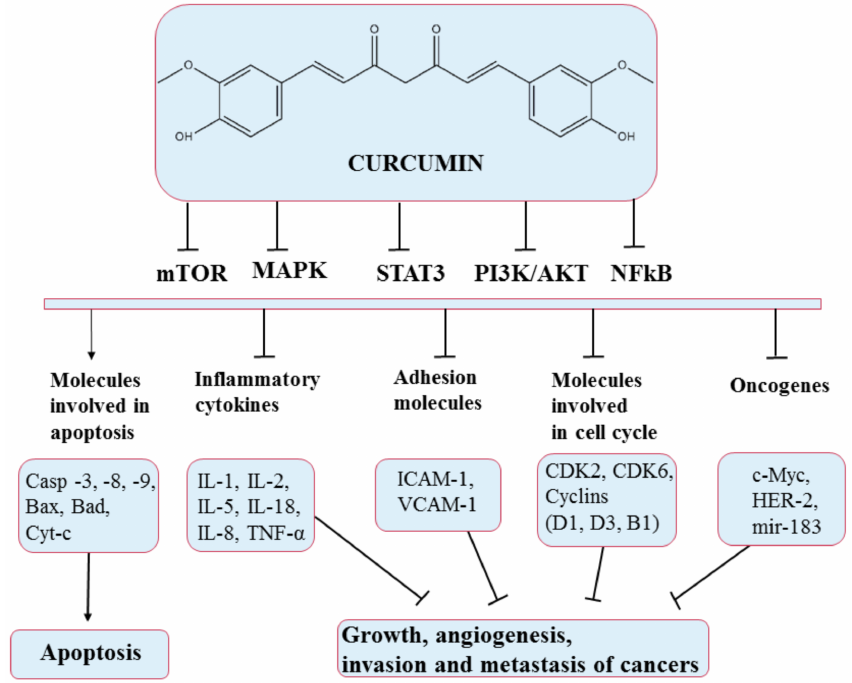
Figure 6. Chemical structure of curcumin and mechanism of action of curcumin through differ- ent molecular targets, resulting in apoptosis or growth suppression, angiogenesis, invasion, and metastasis of